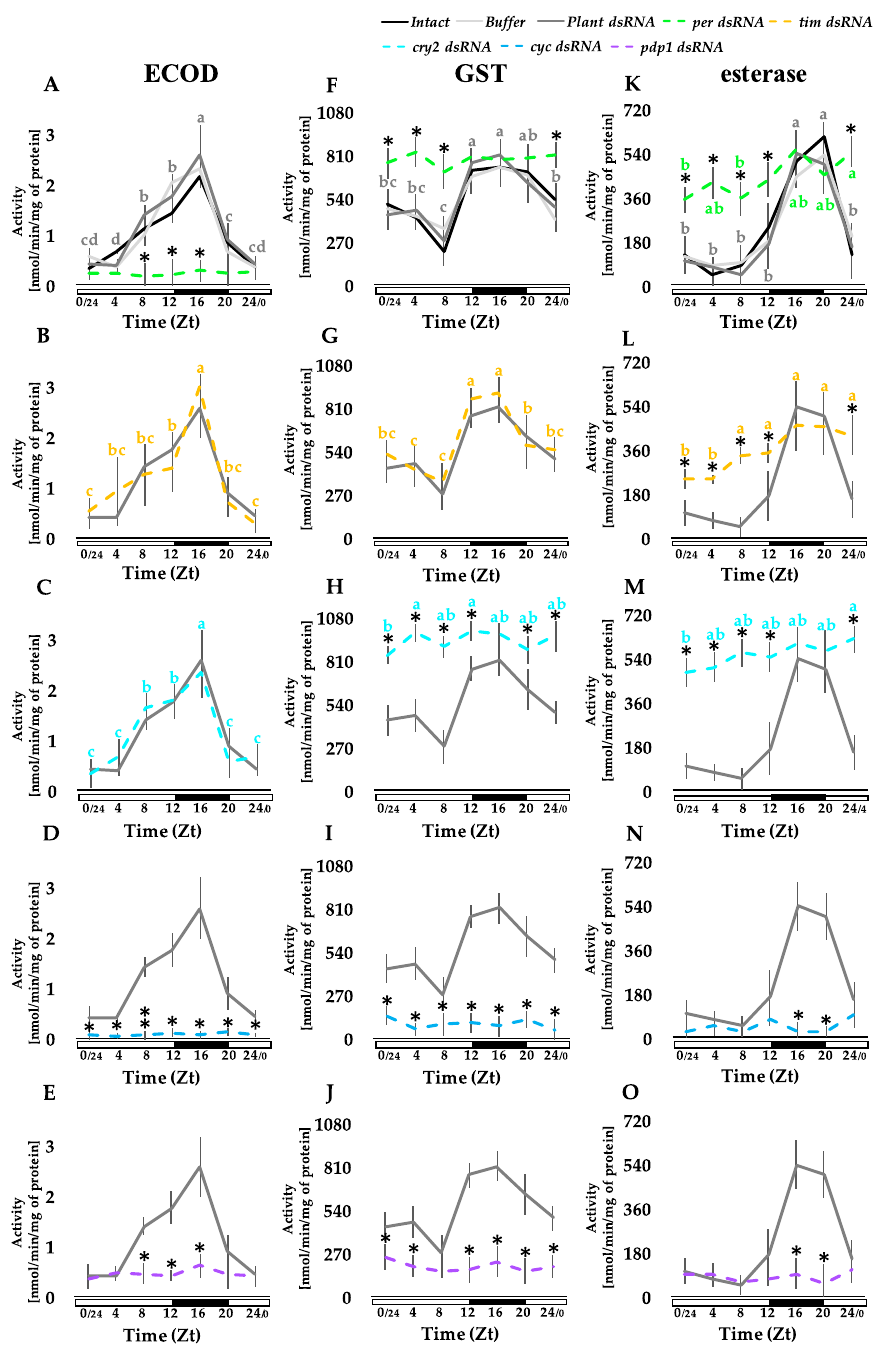
Figure 3. Changes of the daily patterns in the activity of xenobiotic metabolizing enzymes in the midgut caused by RNAi-mediated disruption of clock gene expression. The activities of ECOD ( A – E ), GST ( F – J ), and esterase ( K – O ) were analyzed in the fat body of the larvae whose molecular os- cillator was altered by injection of clock gene dsRNA (as in experiments whose results were pre- sented in Figure 2). Statistical analyses of the obtained data and the results presentation on the graphs are analogous to those described in Figure 2.